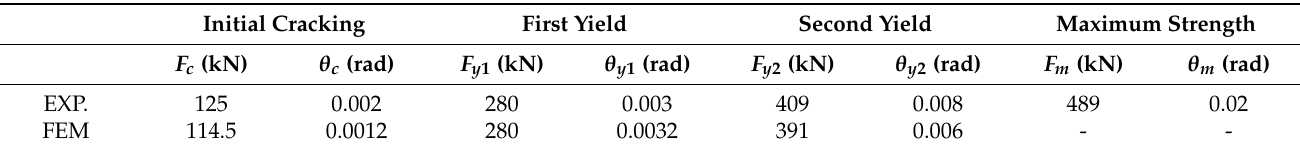
Table 3. Experimental data [15] and FE predictions.